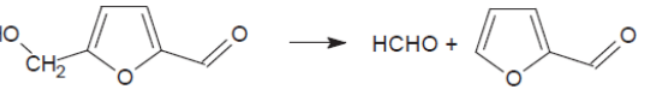
Table 6. Results of analysis of FRs degradation products after washing in water and subsequent rinsing. ID Chemical Compound